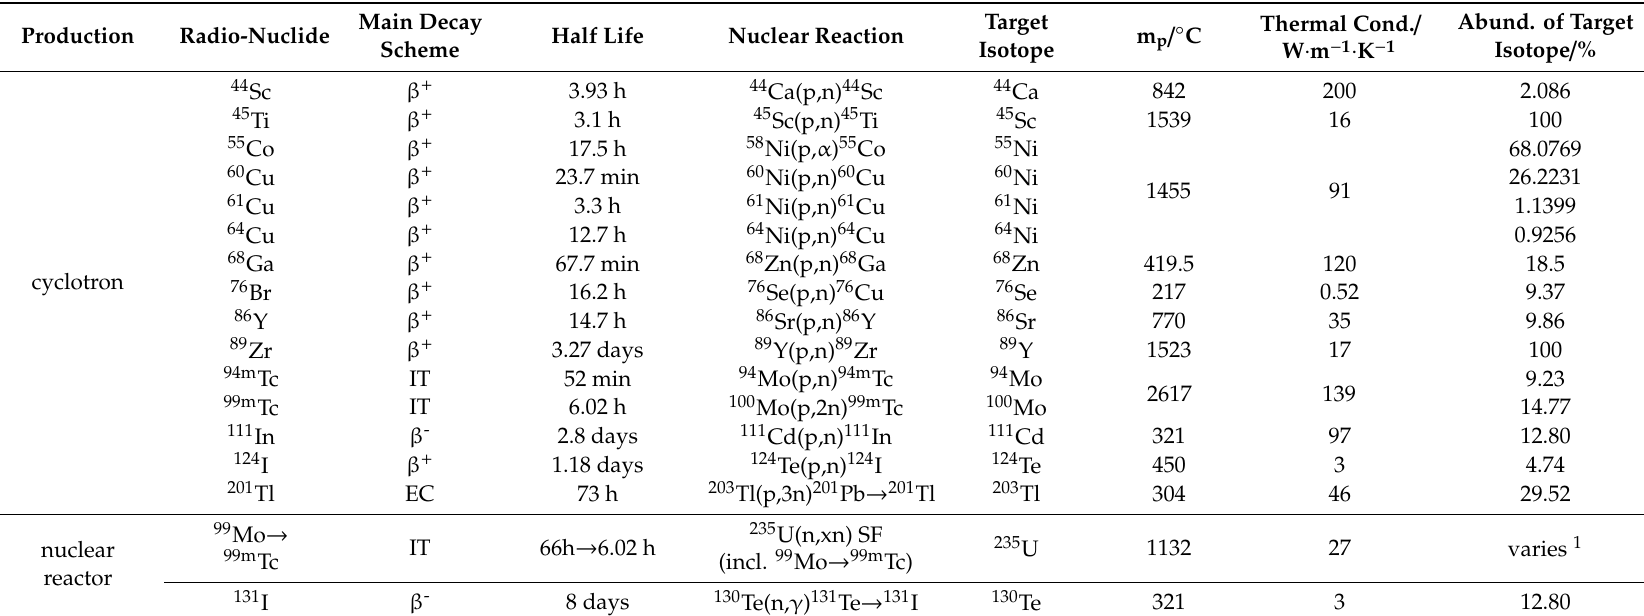
Table 1. Characterization of selected cyclotron and reactor radioisotopes for nuclear imagining